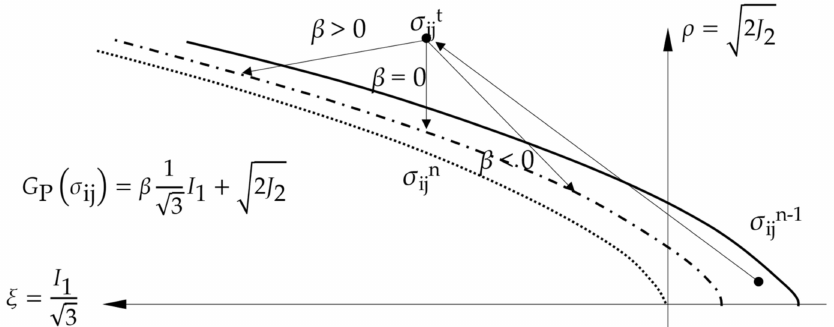
Figure 7. Plastic predictor-corrector algorithm.